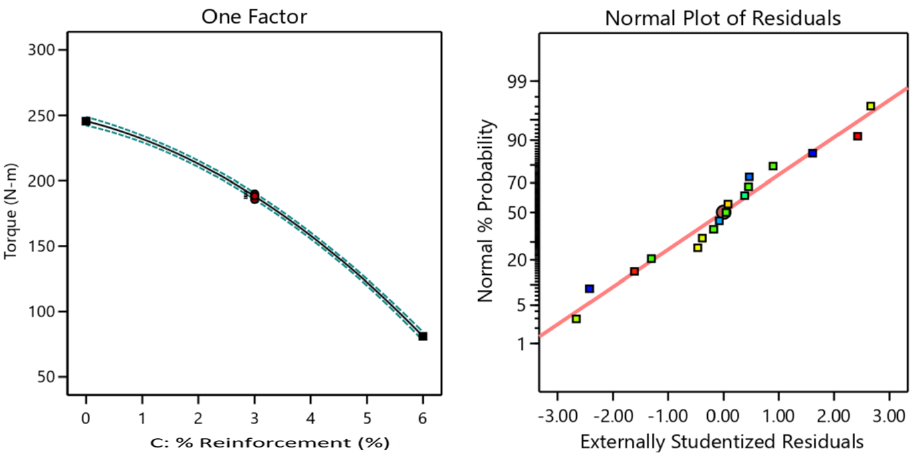
Figure 12. Effect of reinforcement and normal probability plot for